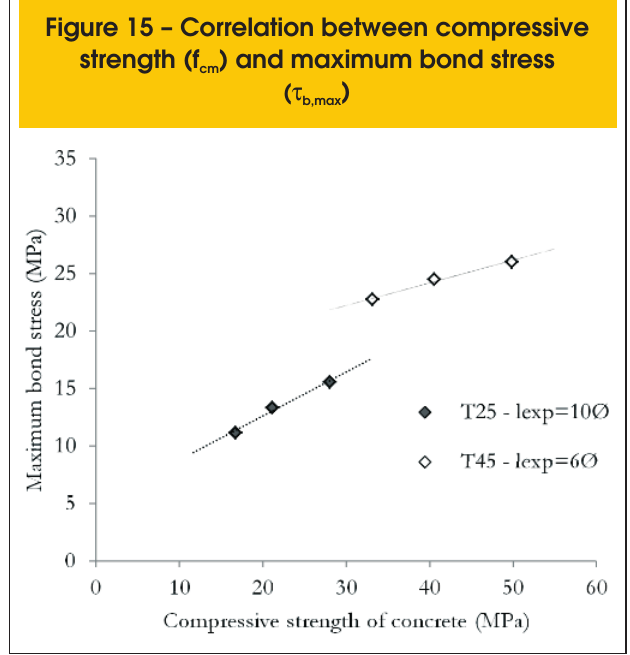
Figure 15 – Correlation between compressive strength (f ) and maximum bond stress cm